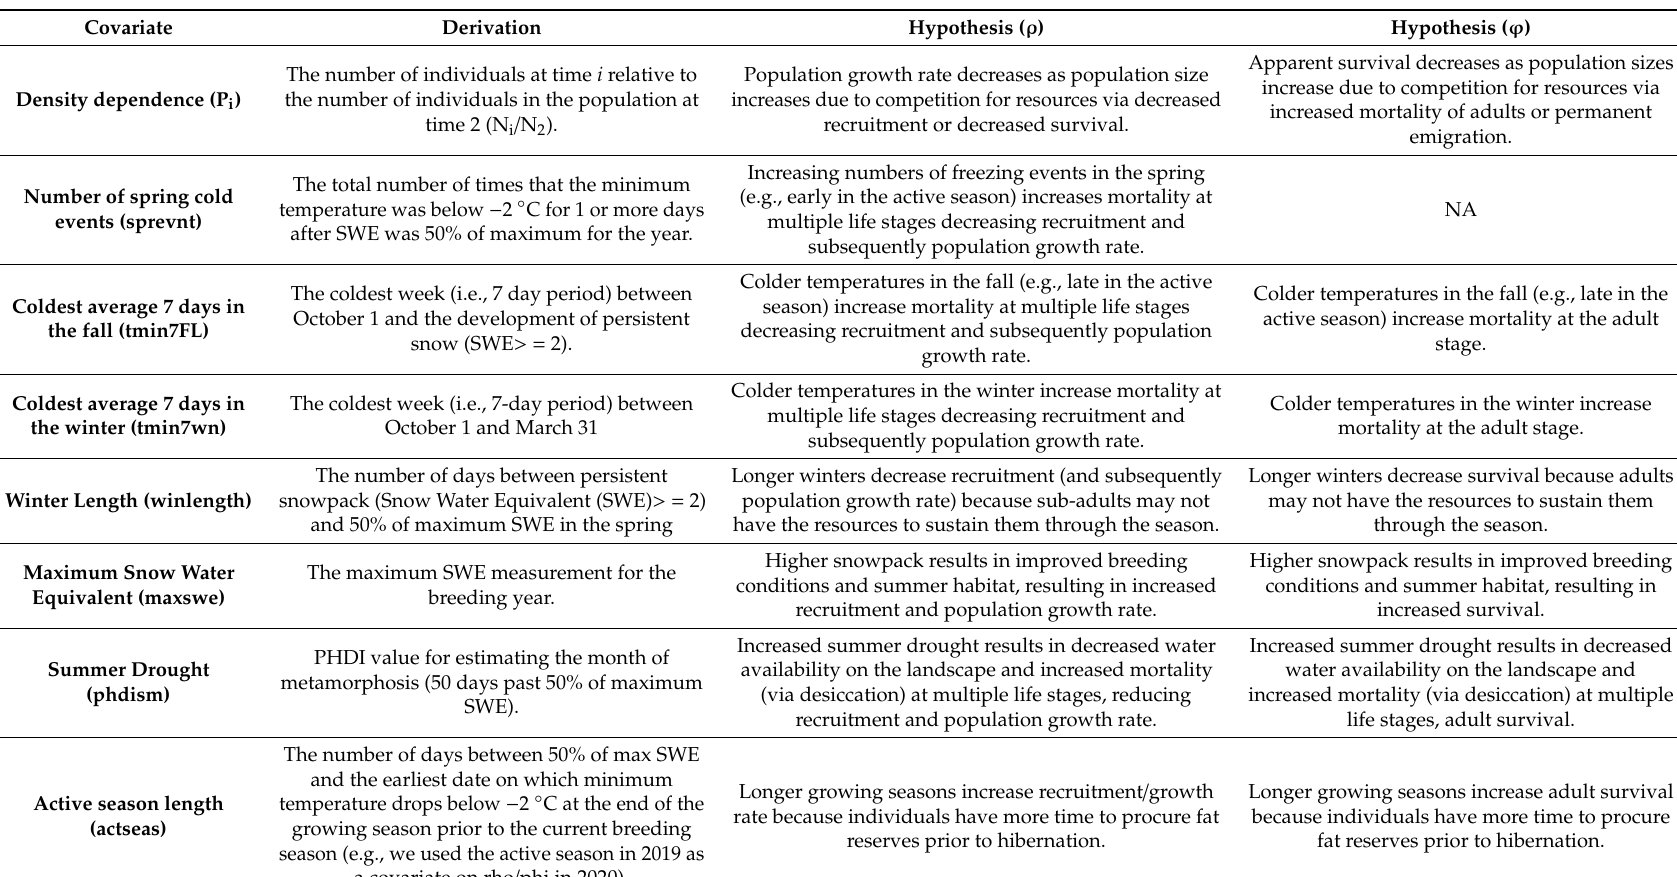
Table 1. Description of covariate derivations and our hypotheses for the e ff ects on population growth rate ( ρ ) and apparent survival probability ( ϕ ). ‘NA’ indicates that the covariate was not included in the model. Parentheticals in the covariate column indicate how the term was written in the model (e.g., Equations (1) and (2)